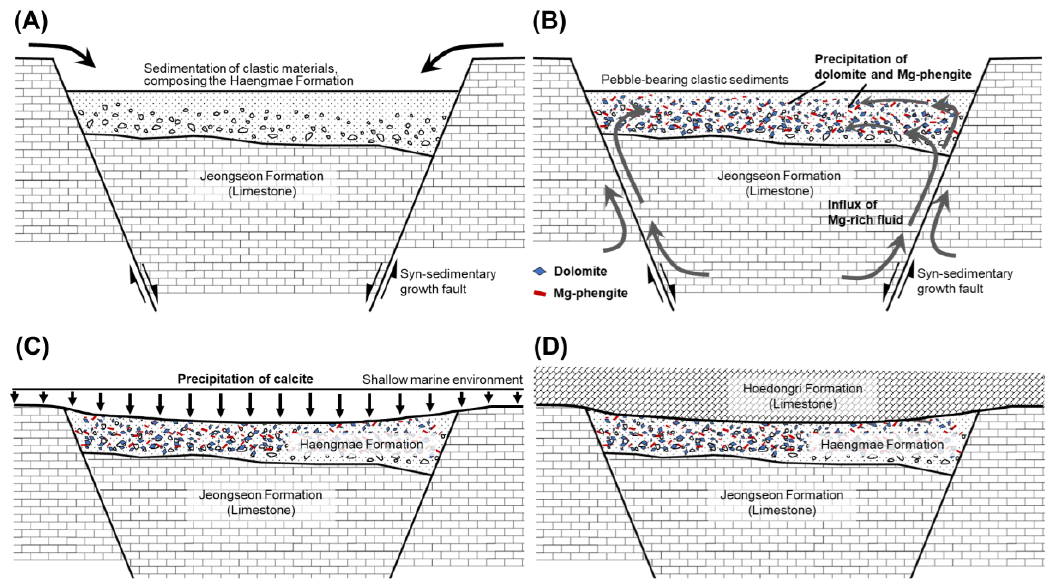
Figure 11. A genetic model for Mg-phengite in the Haengmae Formation. ( A ) In the initial stage, detrital clasts, including quartz, dolomite pebbles and rock fragments, etc.; were deposited on the basin being formed by syn-sedimentary growth faults; ( B ) Dolomite and Mg-phengite were precipitated by the influx and infiltration of the highly evolved Mg- and REEs-enriched hydrothermal fluid into the clastic sedimentary rock (Haengmae Formation) as a strata-bound form, syngenetically or during early diagenesis; ( C ) The sedimentary environment changed to shallow marine and calcite was precipitated, which filled the pore spaces of the Haengmae Formation as cement, and ( D ) the continuous deposition of calcite formed the Hoedongri Formation in the later